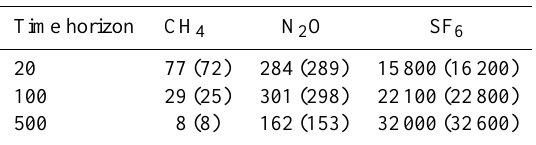
Table 1. IGTP estimates for CH 4 , N 2 O and SF 6 (with GWP values in brackets).